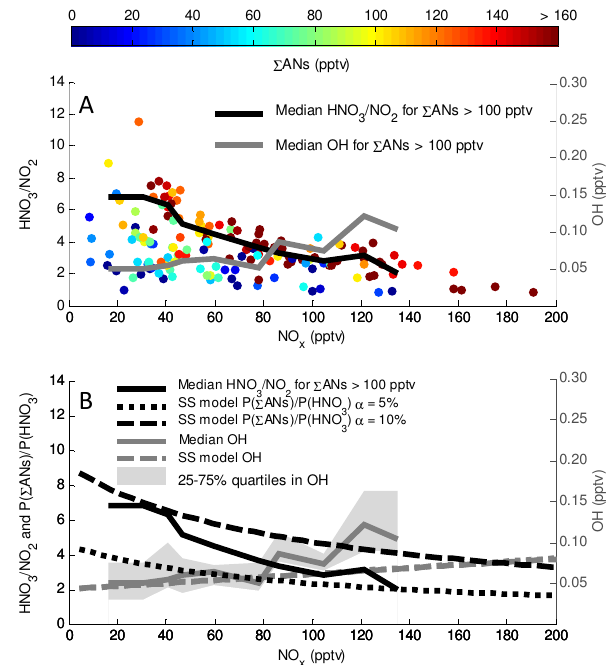
Fig. 5. (A) On the left y-axis is the ratio of HNO 3 (gas + particle) to NO 2 versus NO x colored by 6 ANs concentration. The solid lines are binned median values of points corresponding to 6 ANs concen- trations ≥ 100pptv (55% of the data) for the ratio of HNO 3 to NO 2 (black line, left y-axis) and for OH concentration (grey line, right y- axis). If HNO 3 is in steady-state the ratio of HNO 3 to NO 2 should be equivalent to OH. The difference in these two lines as a func- tion of NOx indicates the possibility of additional HNO 3 sources. (B) Comparison between the ARCTAS measurements and predic- tions from the steady-state model described in Browne and Cohen (2012). The solid lines are the same as in Fig. 5a with the shaded grey area representing the interquartile range of the OH concentra- tion. The dashed and dotted black lines represent the steady- state model predictions of the ratio of 6 ANs production to HNO 3 pro- duction for branching ratios of 10% and 5% respectively (left y- axis). The dashed grey line represents the steady-state model pre- diction of the OH concentration (right